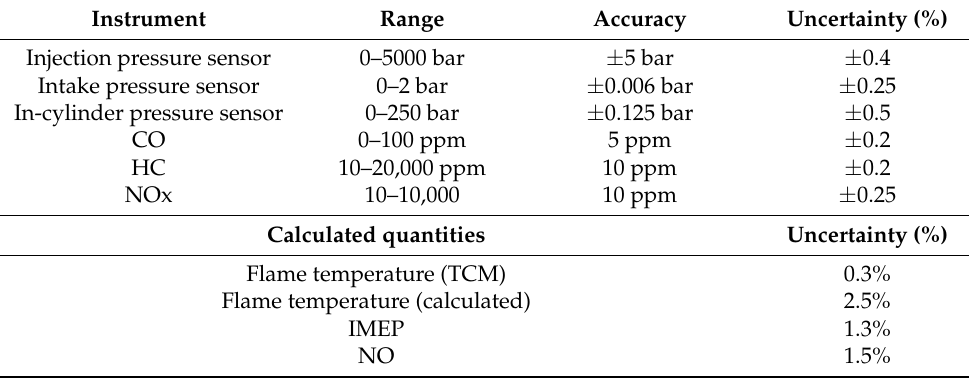
Table 5. The uncertainty in the measurements and the